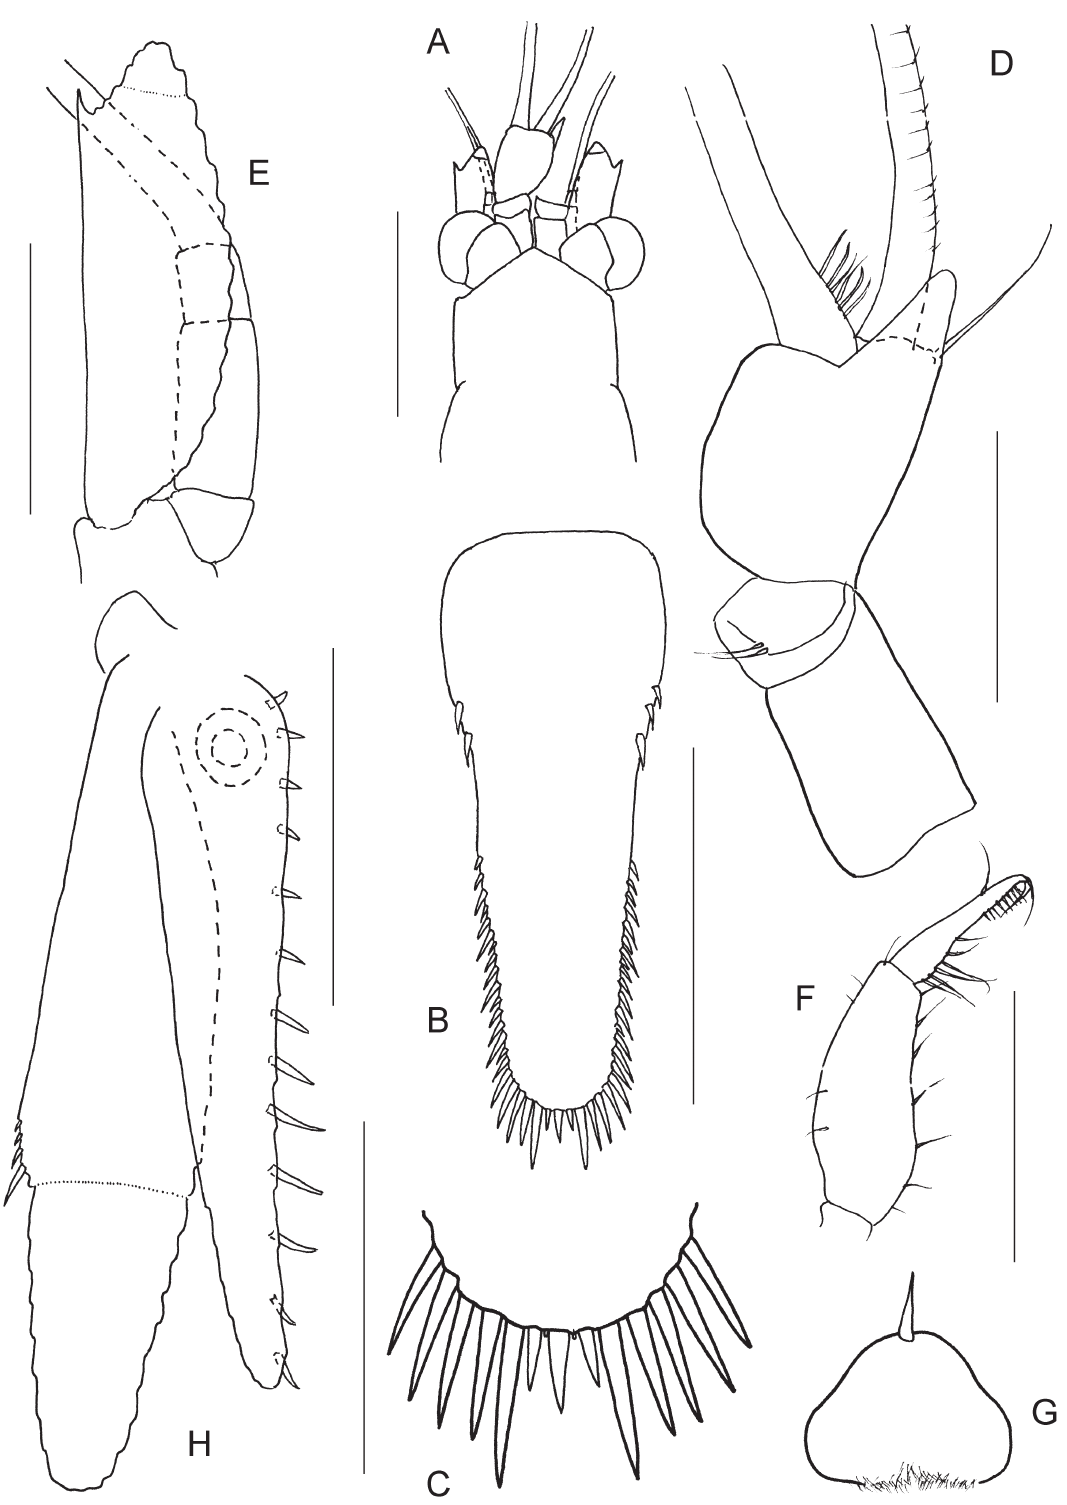
Fig. 32. Siriella cf. chaitiamvongae Murano & Fukuoka, 2008, subadult ♂, Singapore. A . Anterior part of body. B . Telson. C . Posterior margin of telson, dorsal view. D . Antenna 1 peduncle, lateral view. E . Antenna 2 peduncle and antennal scale, dorsal view. F . Mandibular palp, lateral view. G . Labrum. H . Uropods, dorsal view. Scale bars: A = 1 mm; B, D–H = 0.25 mm; C = 0.1